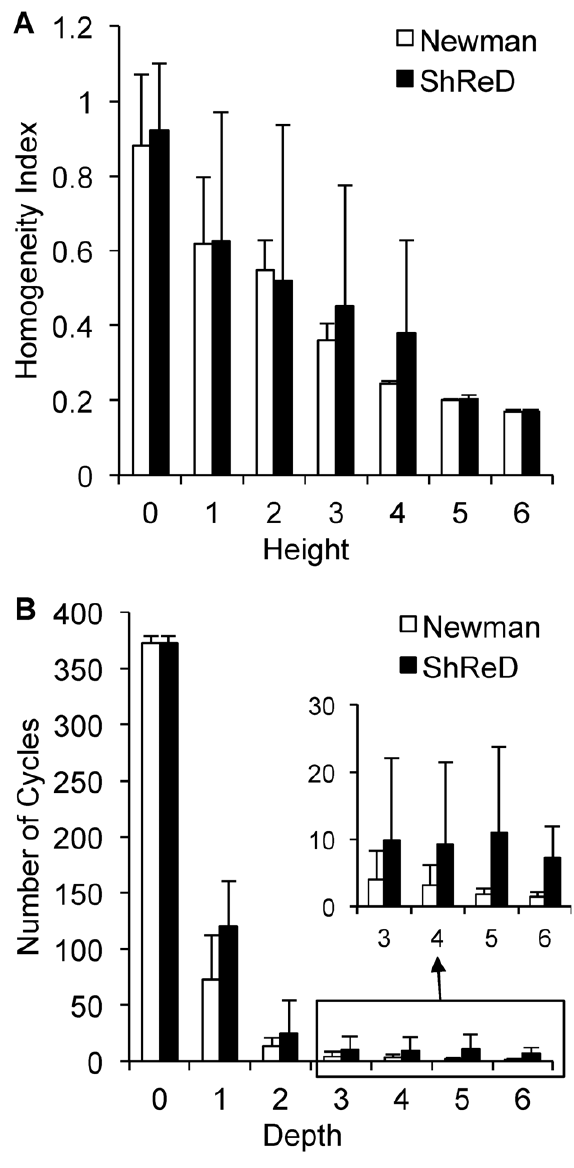
Figure 4. Effects of the partition metric on the properties of EGFR signaling network modules. (A) Homogeneity of modules as a function of partition height (see text in Methods for definition of homogeneity index). (B) Average number of cycles in a module as a function of network depth. Error bars represent one standard deviation.